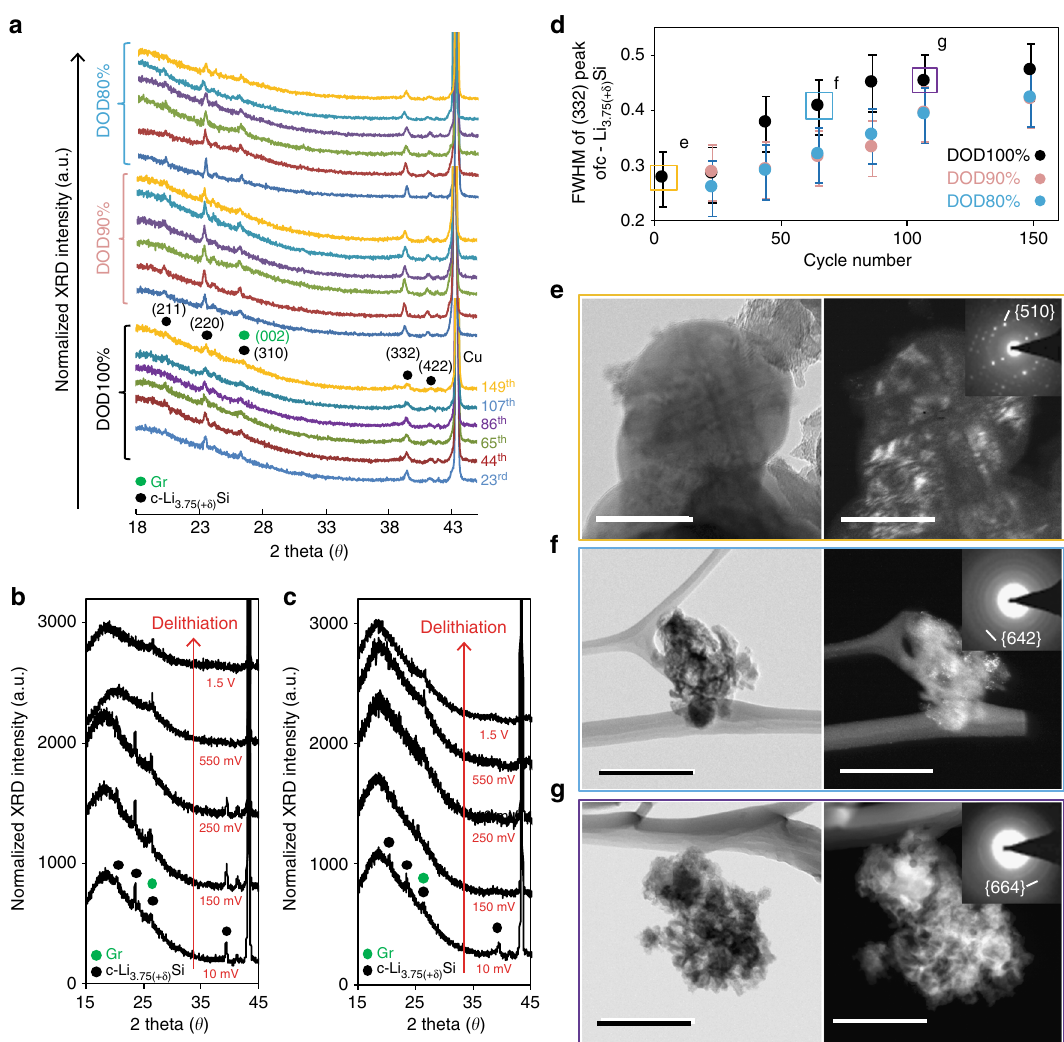
Fig. 6 XRD pro fi les and electron microscopy images of fully lithiated Si. a XRD spectra of fully lithiated Li – Si alloys for type-A electrodes at 10 mV for depth of discharge (DOD)100, 90, and 80% over 150 cycles. XRD spectra at various delithiation potentials under DOD100% at ( b ) the 23 rd cycle and ( c ) the 86 th cycle. In the 23 rd cycle, c-Li 3.75(+ δ ) Si diffraction peaks disappear only after 550 mV on delithiation, while it does so at 150 mV at the 86 th cycle. d Full width of half maximum (FWHM) of the (332) peak in c-Li 3.75(+ δ ) Si XRD pro fi les over 150 cycles for DOD100, 90, and 80%. FWHM for DOD100% saturates near 65 th cycle, while that for DOD90% and 80% continuously increases until the 150 th cycle. Empty squares colored yellow, blue, and purple correspond to fully lithiated electrodes at 10 mV shown in the following electron microscopy images. e – g Bright- fi eld and dark- fi eld TEM images with selected area diffraction pattern (SADP) and index planes shown in inset. The fully lithiated Si in ( e ) the 3 rd cycle, ( f ) the 65 th cycle, and ( g ) the 107 th cycle under DOD100% controls. Scale bars are ( e ) 200 nm and ( f , g ) 500 nm. It is obvious that c-Li 3.75(+ δ ) Si crystals become much smaller in the 65 th and the 107 th cycles, compared to those in the 3 rd cycle, which agrees with the trend seen in ( d